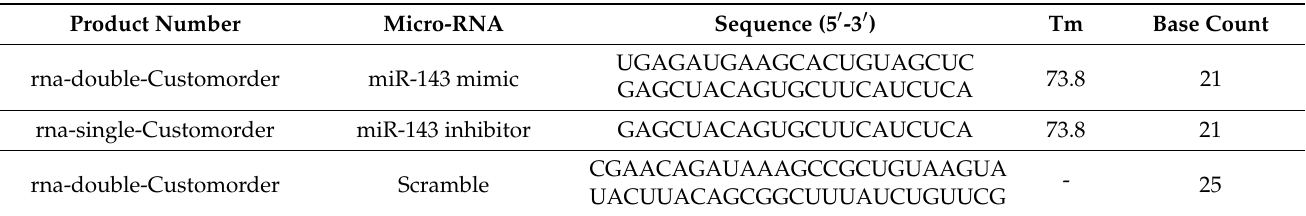
Table 1. micro-RNA-143 and scramble